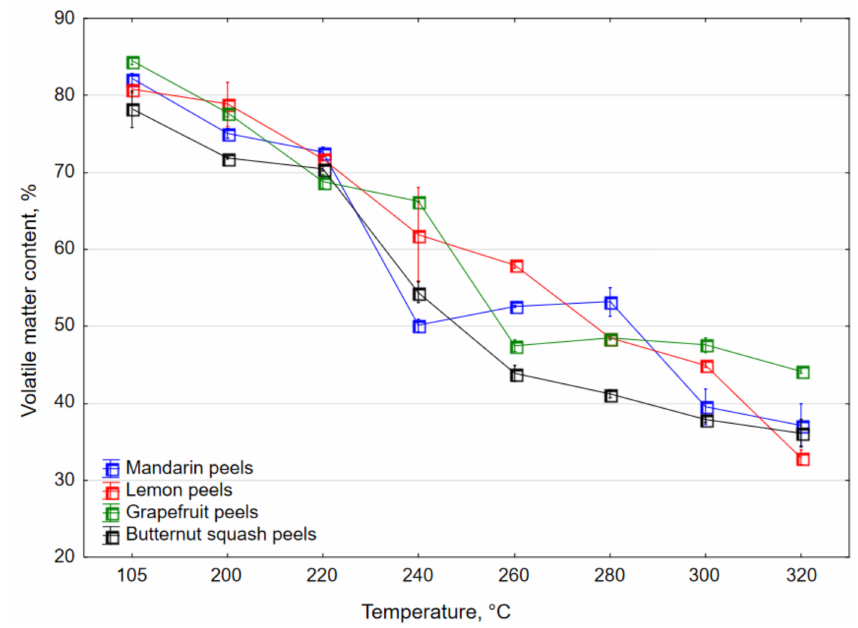
Figure 3. Volatile matter content in the torrefied waste biomass. One of the basic fuel properties is the content of the fixed carbon, which indicates the carbonization rate of the material and affects the caloric value. The fixed carbon content was calculated as the difference between unity and MC, AC, and VMC. For the tested materials, it was from ca. 10% (for dried raw material) up to 50% (for torrefied biomass at 320 ◦ C) (Figure